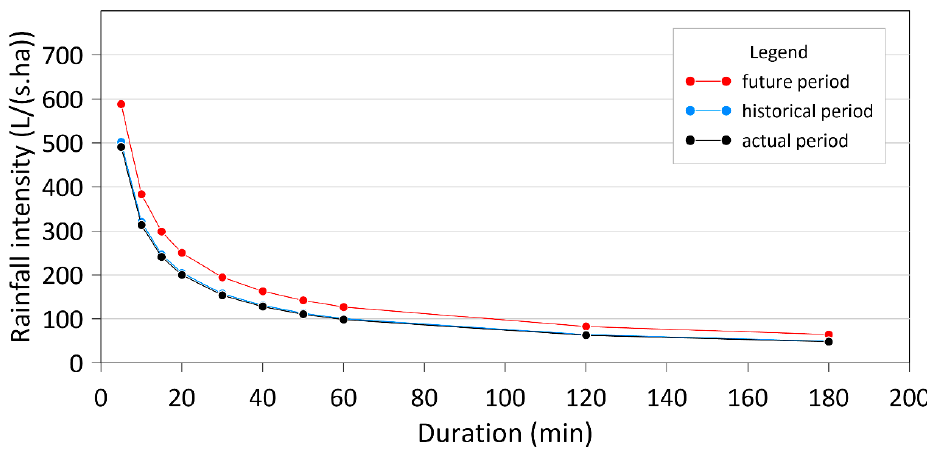
Figure 10. IDF curves for the Vyšná Boca climatological station for the periodicity p = 0.01.